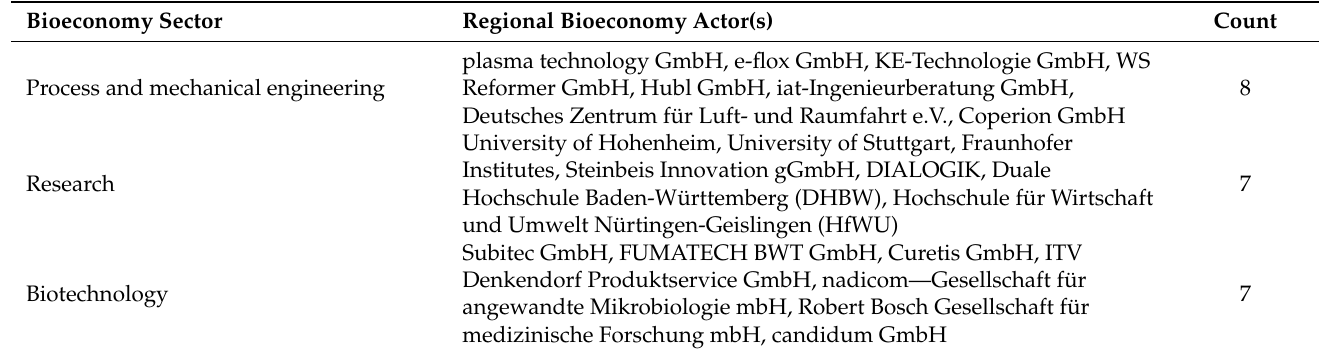
Table 3. Classification of the regional actors in the bioeconomy network of the Stuttgart region by